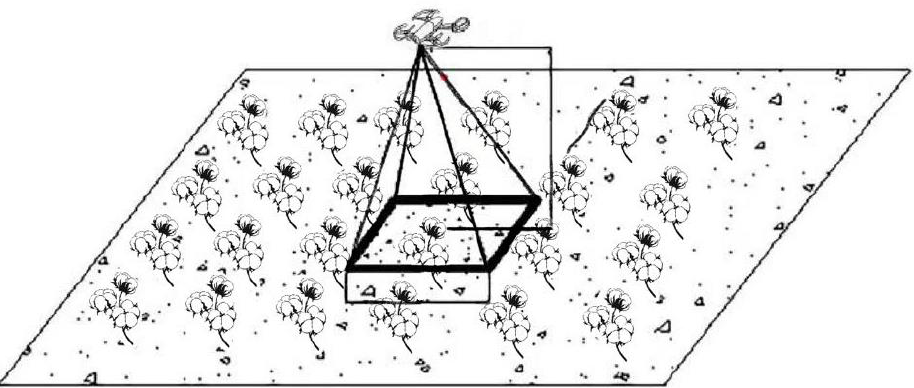
Figure 1. Shooting method. Figure 1. shooting method.